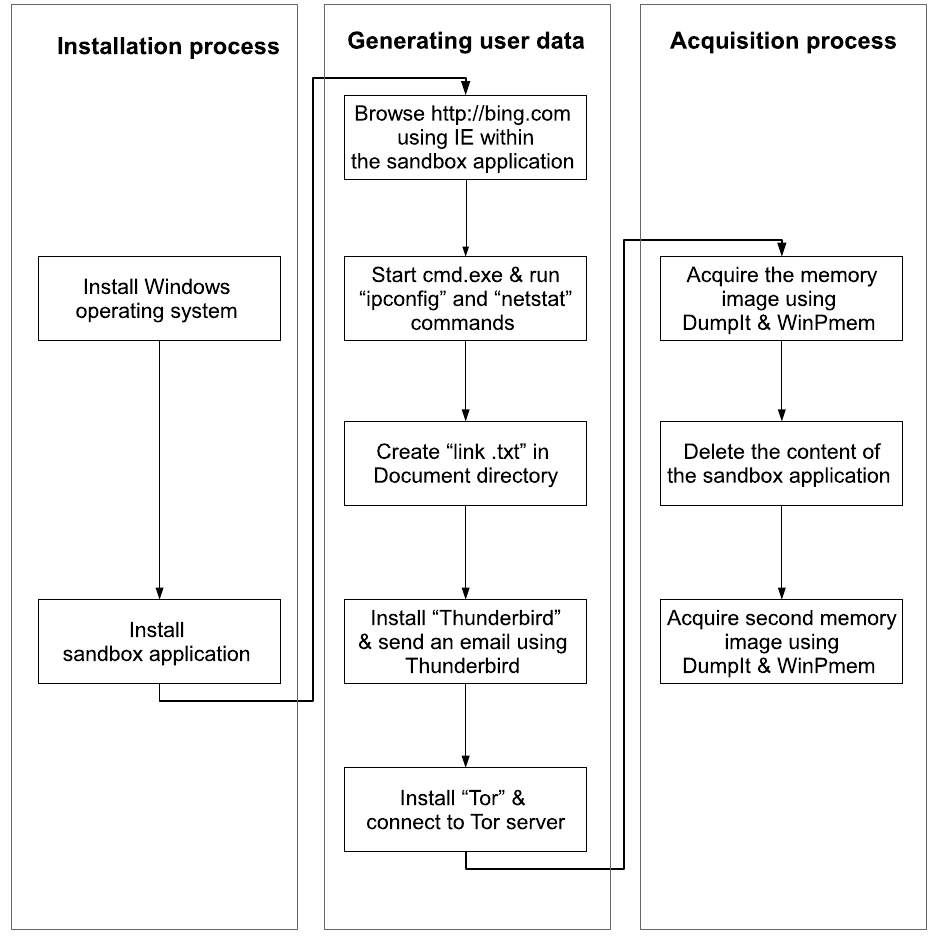
Figure 1. Experiments setup for analysing sandbox applications on Windows